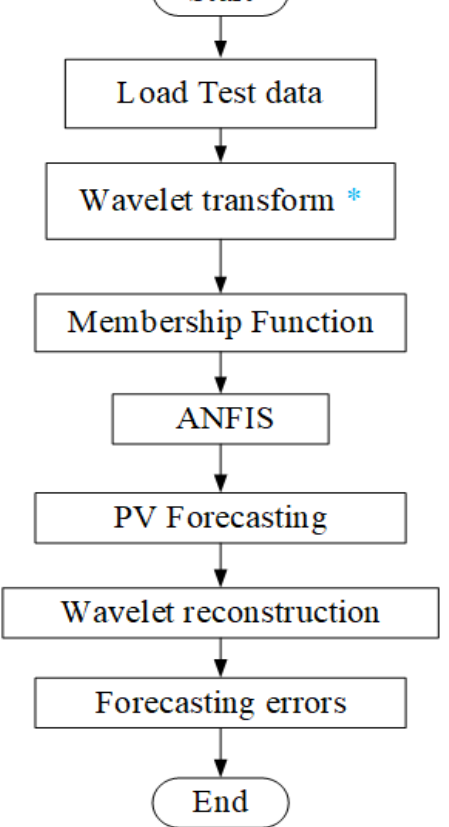
Figure 5. Wavelet-ANFIS testing flowchart. The asterisk (*) indicates that the test dataset wavelet transforms are acquired by applying the wavelet transform function used to decompose the train- ing